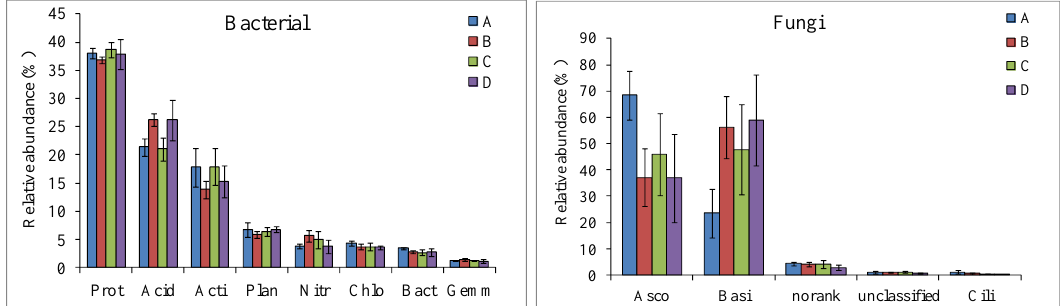
Figure 1. The composition and relative abundance of the soil microbial community at the phylum level. Prot indicates Proteobacteria , Acid indicates Acidobacteria , Acti indicates Actinobacteria , Plan indicates Planctomycetes , Nitr indicates Nitrospirae , Chlo indicates Chloroflexi , Bact indicates Bacteroidetes , Gemm indicates Gemmatimonadetes , Asco indicates Ascomycota, Basi indicates Basidiomycota , norank indicates norank_k__Fungi , unclassified indicates unclassified_k__Fungi , and Cili indicates Ciliophora . A indicates close-to-nature forest management (CNFM), B indicates structure-based forest management (SBFM), C indicates unmanaged control (CK), and D indicate secondary forest comprehensive silviculture (SFCS).